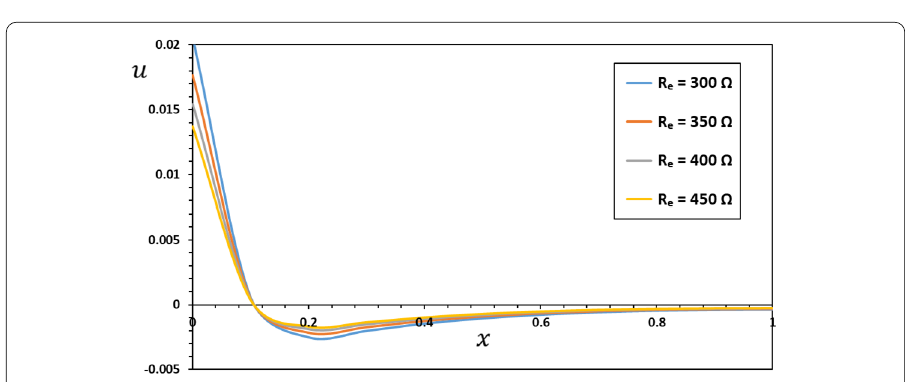
Figure 16 The effect of electric resistance Re on the variation of displacement u